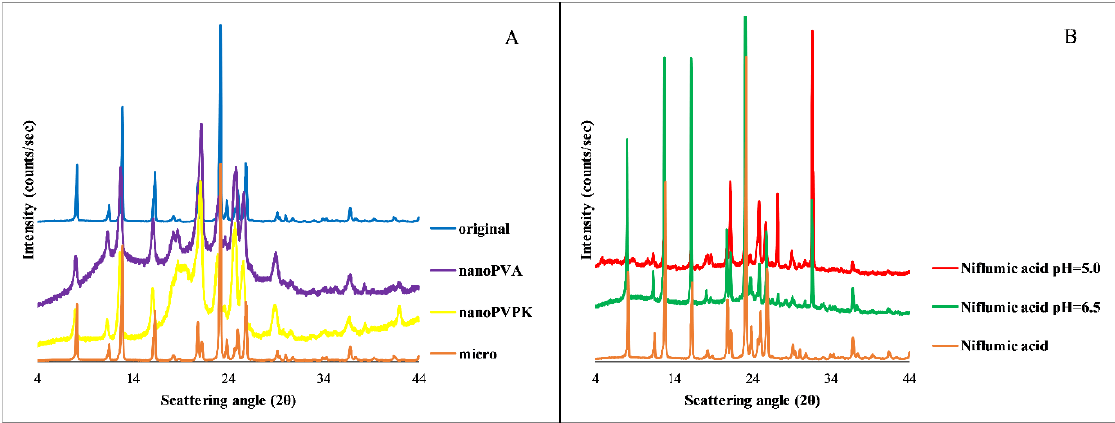
Figure 9. PXRD diffractogram of the original, micronized and nanonized niflumic acid ( A ) and the samples from the solubility measurements (pH = 6.5 and pH = 5.0) compared to the solid niflumic acid starting compound ( B ).